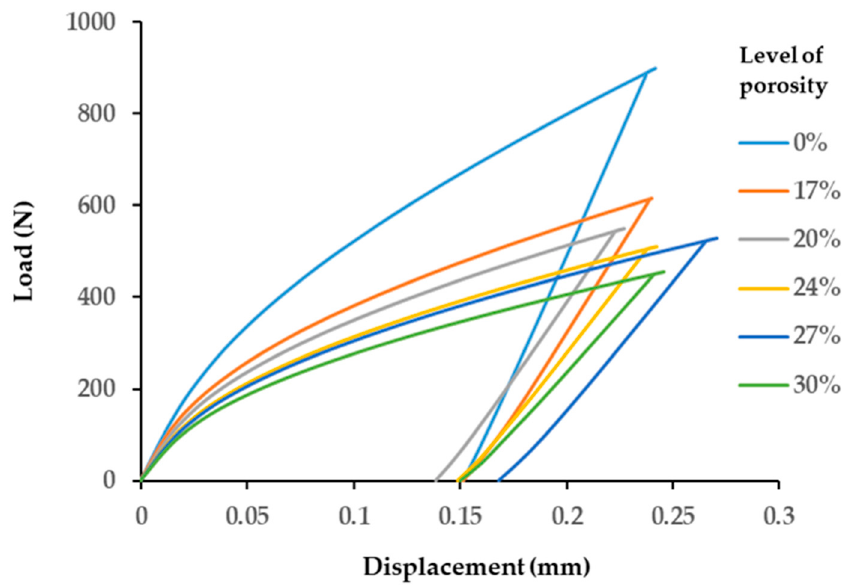
Figure 2. The load–displacement response of simulated plates with different levels of porosity.